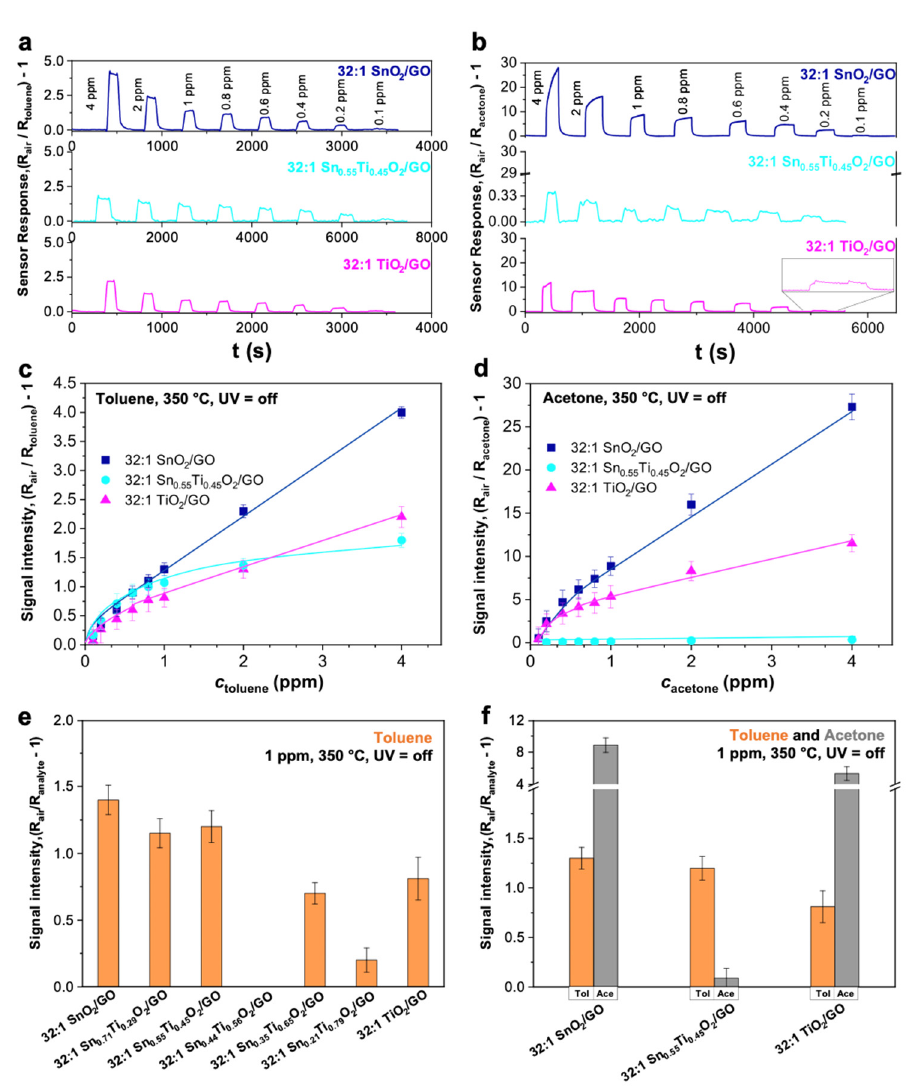
Figure 4. 32:1 SnO 2 /GO (blue line), 32:1 Sn 0.55 Ti 0.45 O 2 /GO (cyan line) and 32:1 TiO 2 /GO (fuchsia line) sensor signals towards ( a ) toluene and ( b ) acetone molecules. Sensor response intensities towards ( c ) toluene and ( d ) acetone species. ( e ) Histograms displaying a comparison of the response intensity obtained with the solid solutions towards 1 ppm of toluene analyte. ( f ) Comparison of the intensities at 1 ppm of toluene (orange) and acetone (grey) obtained with the most promising 32:1 SnO 2 /GO, 32:1 TiO 2 /GO and 32:1 Sn 0.55 Ti 0.45 O 2 /GO samples. Tests were carried out in simulated air (20% O 2 – 80% N 2 ) at 350 °C, without UV light.